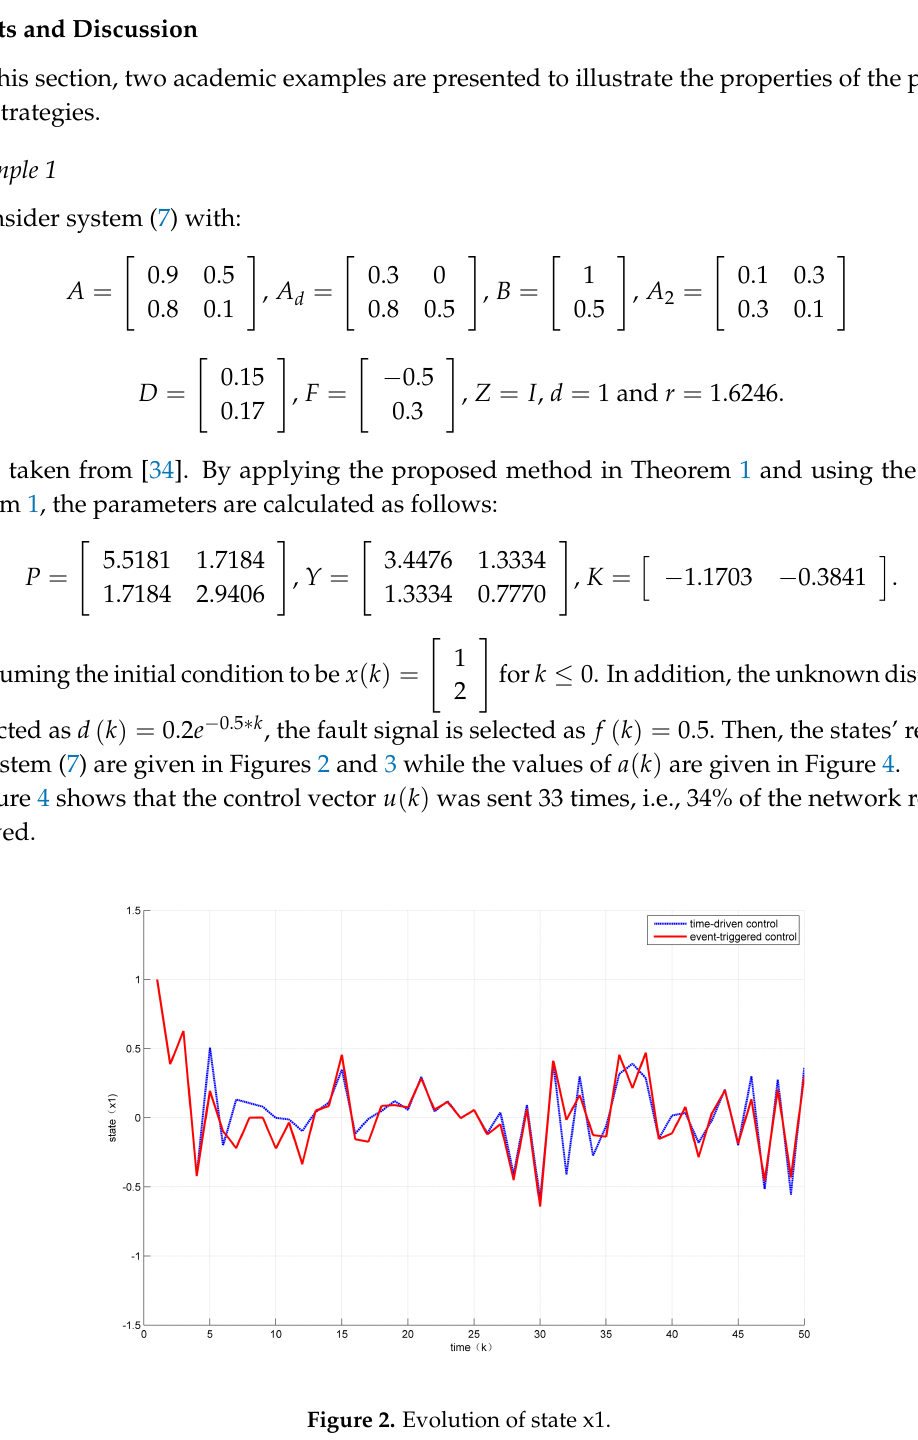
Figure 2. Evolution of state